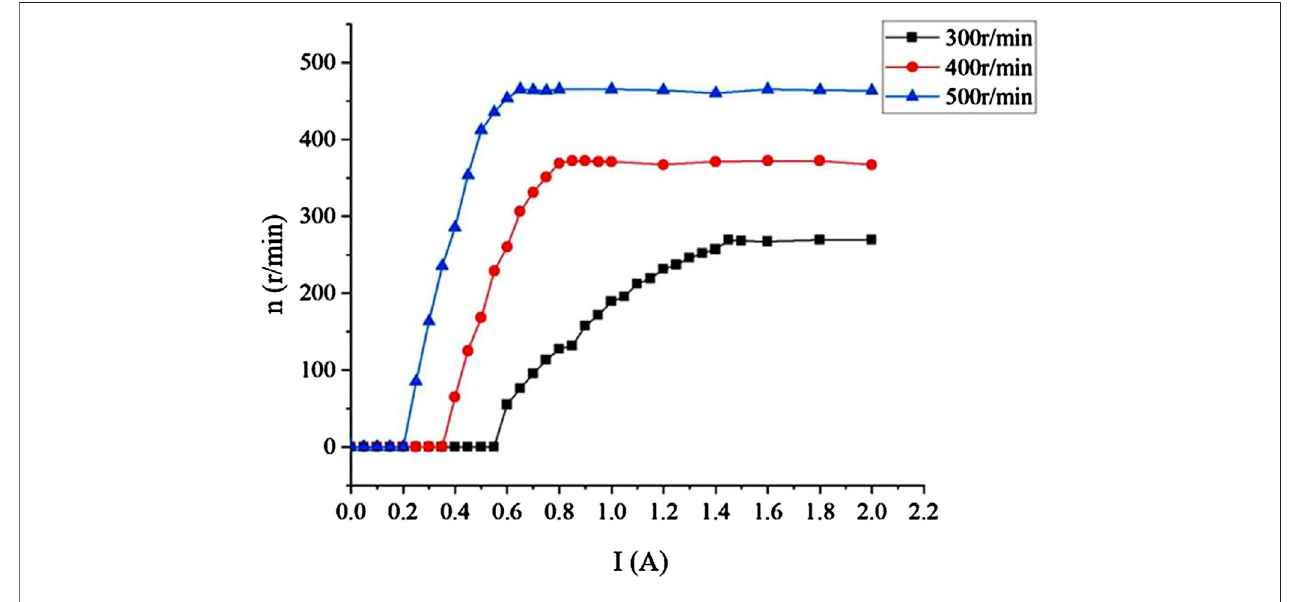
FIGURE 6 | Dependence of output speed on the excitation current.